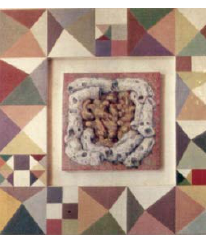
Figure 12-3 El Nashar painting Figure 12-4 El Nashar